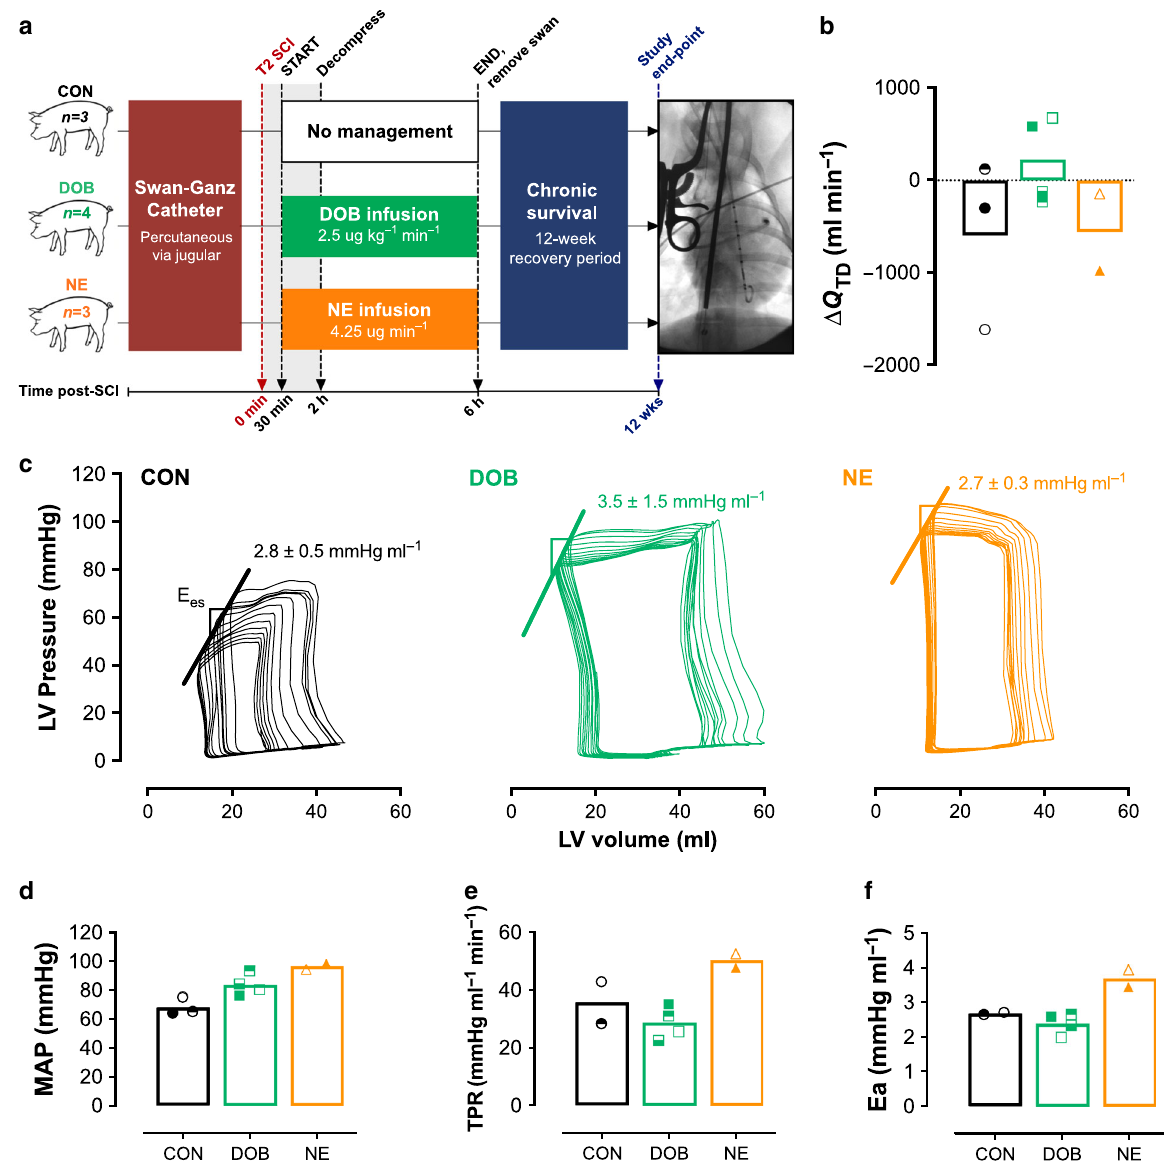
Fig. 6 Long-term cardiovascular outcomes in animals with T2 SCI (12-week survival). a Animals were randomized to receive no treatment (control, CON; n = 3), dobutamine (DOB, n = 4), or norepinephrine (NE, n = 3) treatment. Prior to injury, animals were instrumented with a Swan-Ganz catheter for thermodilution measures of cardiac output (Q TD ). Animals received a T2 SCI with hemodynamic management starting at 30 mins post-SCI and continued until 6 h post-SCI, at which point the Swan-Ganz catheter was removed. Animals were recovered and survived for 12 weeks. At study endpoint, animals were fully instrumented for cardiovascular assessments as in experiments 1 and 2. b All bar plots represent means, and symbols represent data